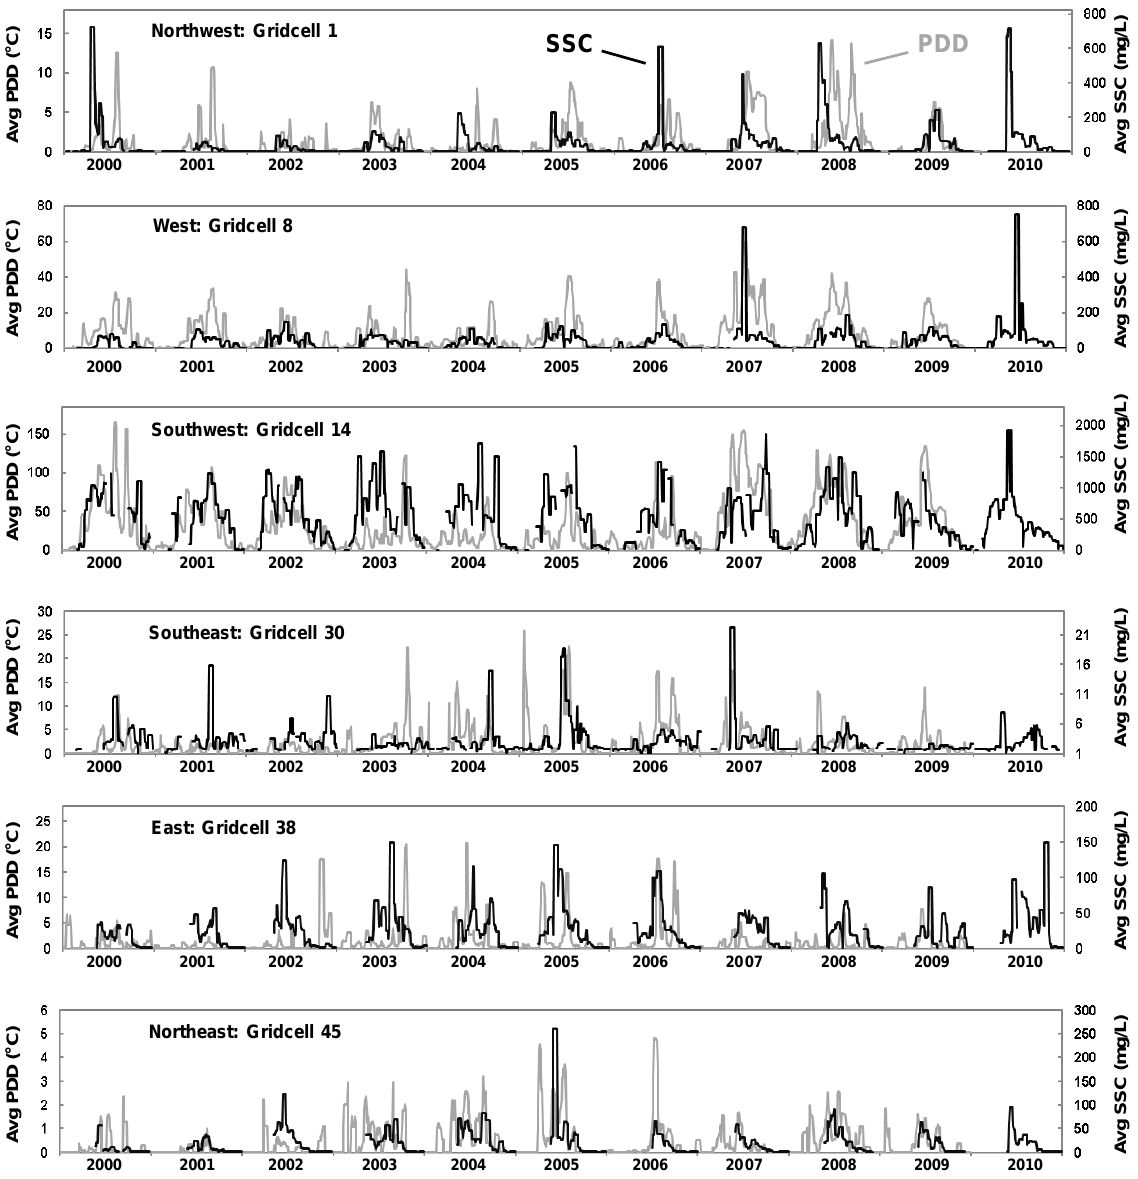
Fig. 9. Examples of high frequency time series of SSC and PDD for one gridcell in each of the six regions from 2000–2009. SSC is displayed for 2010 but not used in analysis due to PDD only being available up to 2009.